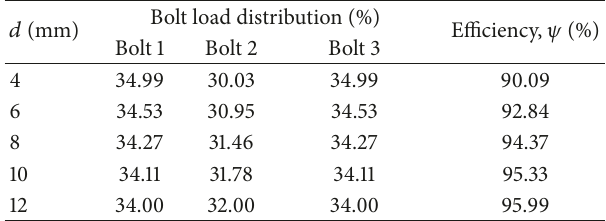
Table 6: Bolt load distribution for variation in bolt